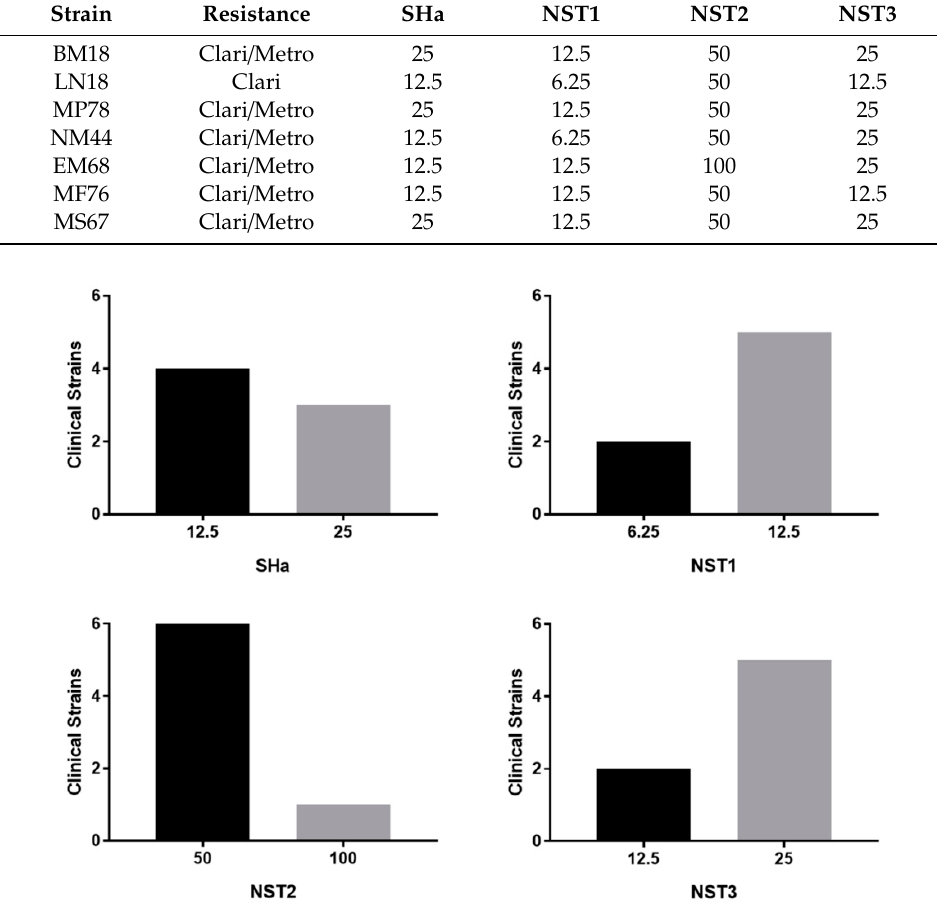
Figure 7. Graphical representation of the repartition of the MIC values of temporin-SHa, NST1, NST2, and NST3 against clinical strains of H. pylori . X-axis are MIC values of the peptides in µ M. Y-axis indicate the number of clinical strains for each MIC values. Table 6. Evaluation of the impact of mucins or pepsin on the activity of temporin-SHa, NST1, NST2, NST3. The impact of gastric factors (mucus, acidic pH, and pepsin) on the activity of temporin-SHa and its analogs on H. pylori (ATCC 43504) was evaluated as explained in Materials and Methods. Peptide MIC in the presence of mucins (µM)